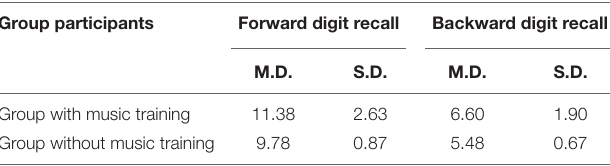
TABLE 2 | Mean differences and standard deviations for the two groups for all working memory measures.